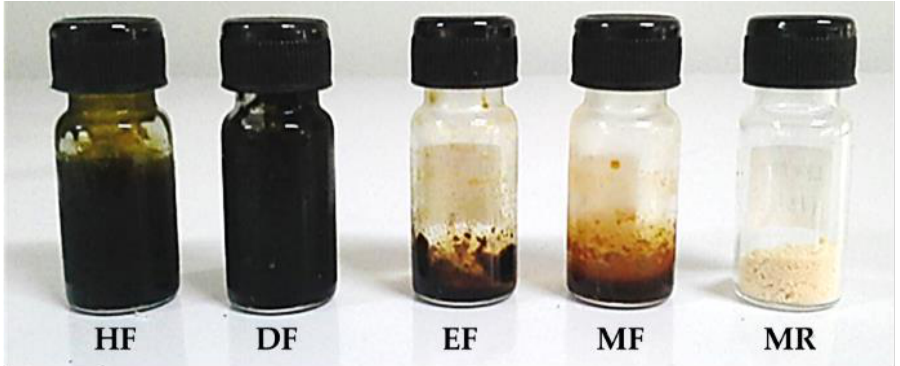
Figure 2. Physical appearances of E. debile hexane fraction (HF), dichloromethane fraction (DF), ethyl acetate fraction (EF), methanol fraction (MF), and methanol insoluble residue (MR).